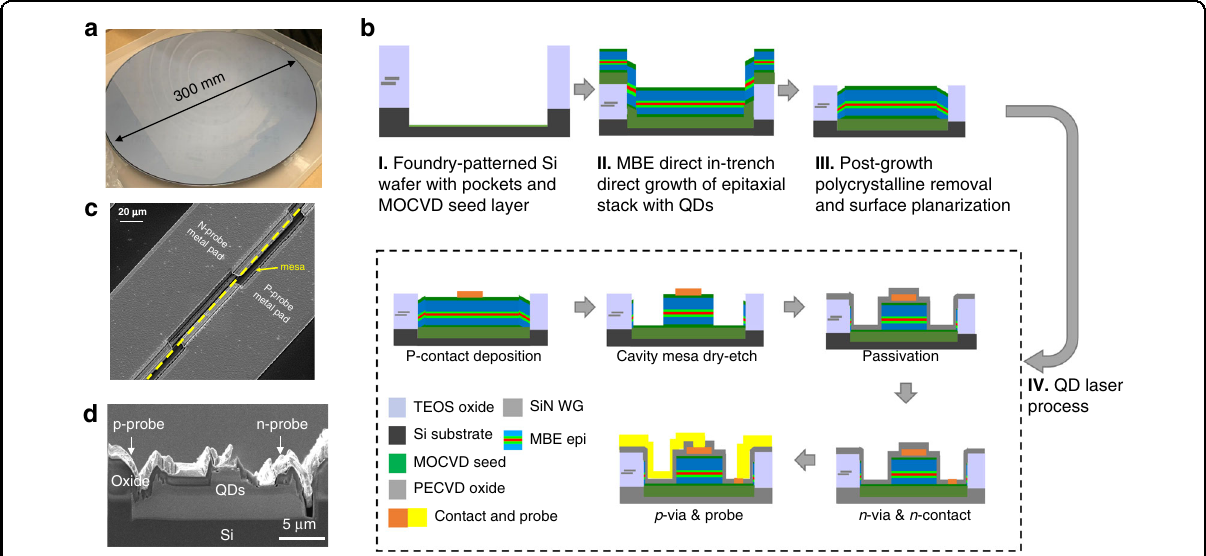
Fig. 4 Fabrication process of the in-pocket laser. a As-grown 300 mm wafer from IQE, covered with polycrystal III – V. b Simpli fi ed fabrication fl ow for laser fabrication, not drawn to scale. c Top-down view of an as-fabricated device. d Cross-section SEM of the as-cleaved in-pocket